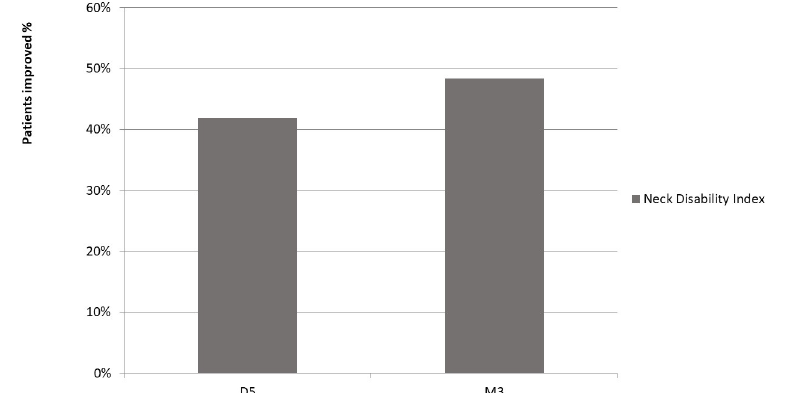
Fig 3. Proportion of patients with improvement in disability above the